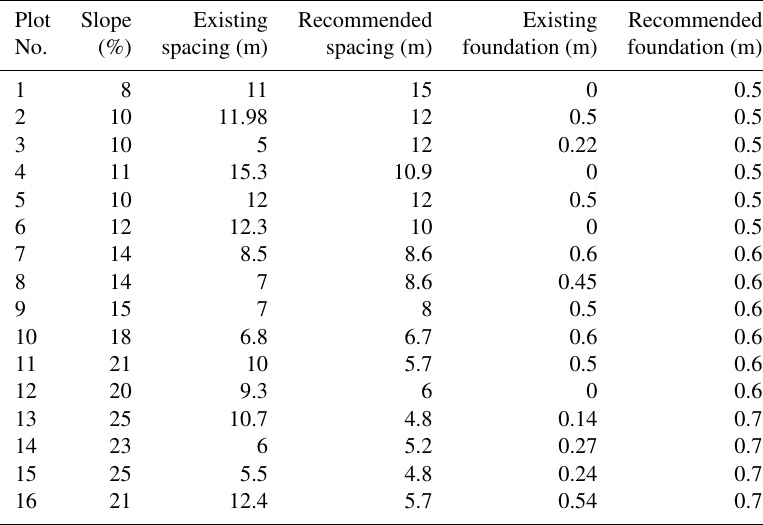
Table 6. Average size of measured and recommended check dam spacing and measured and recommended check dam foundations per plot during the measurement period at the study